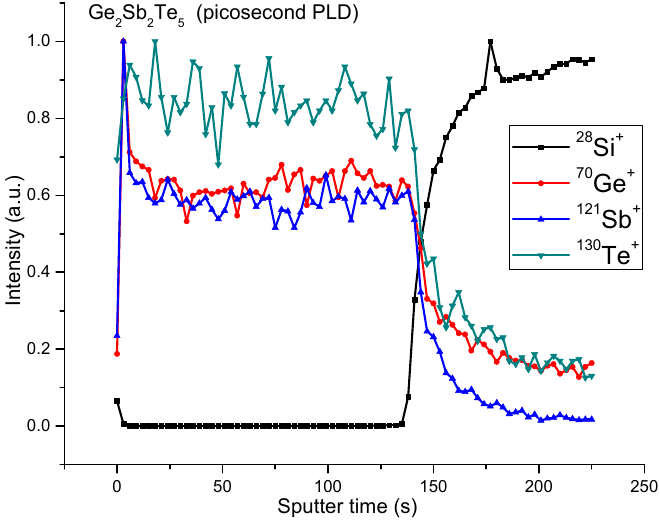
Figure 5. The ToF-SIMS depth profiles for the Ge 2 Sb 2 Te 5 thin film deposited by ps-PLD (target-to-substrate distance = 3 cm, fluence = 0.3 J / cm 2 , deposition time = 60 min).